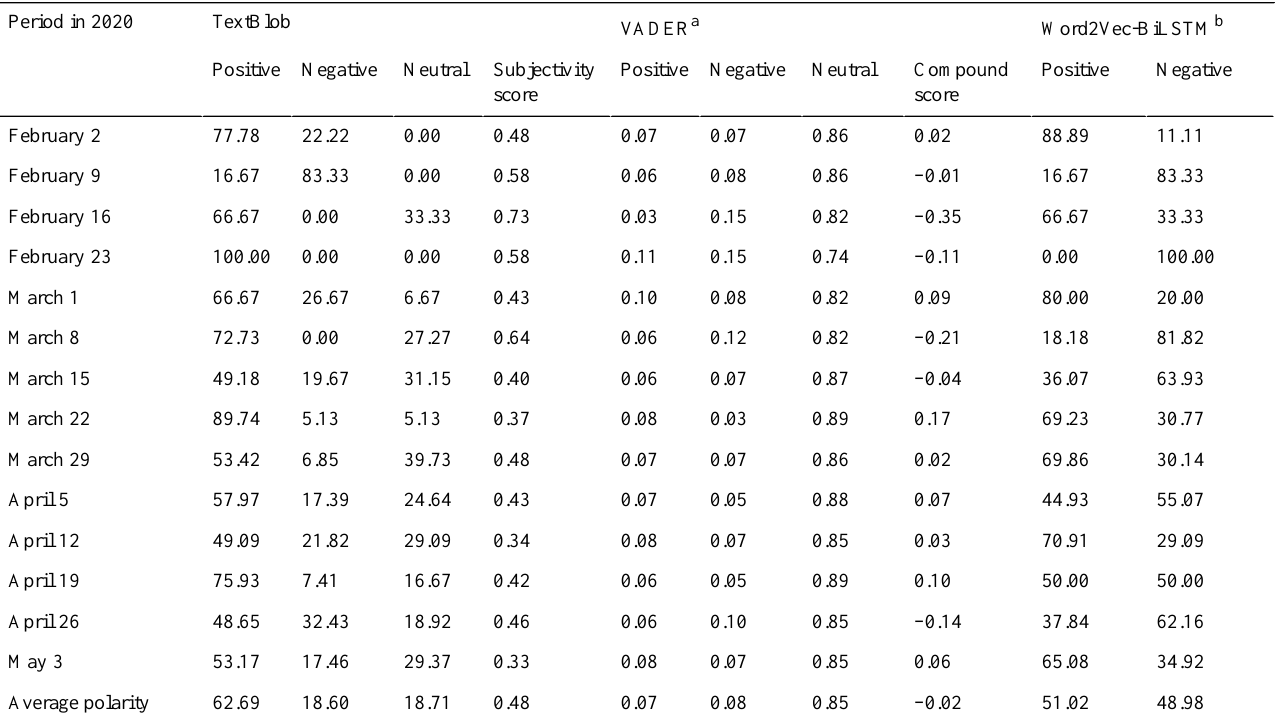
Table 1. Sentiment polarities in media communications (Google News headlines or descriptions) analyzed using the TextBlob, VADER, and Word2Vec-BiLSTM